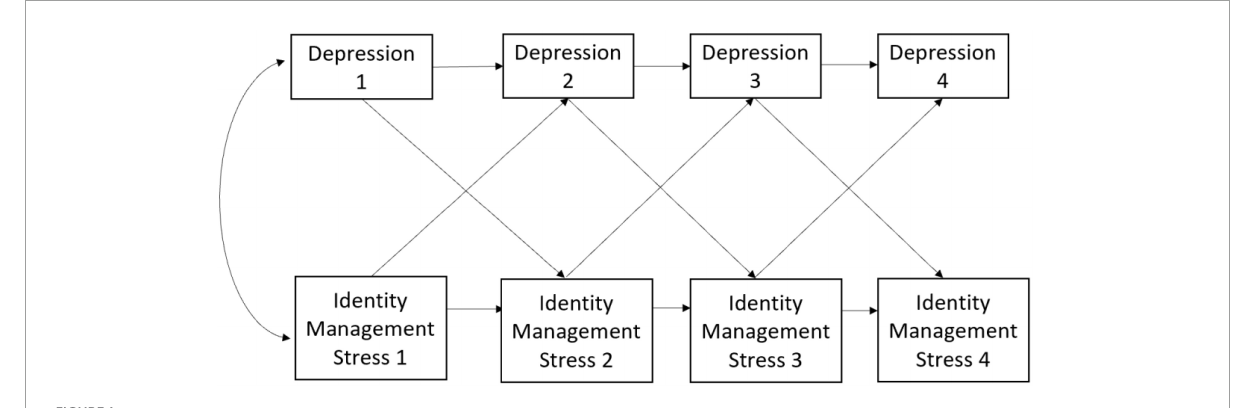
FIGURE1 Time-sequential associations between depression symptoms and identity